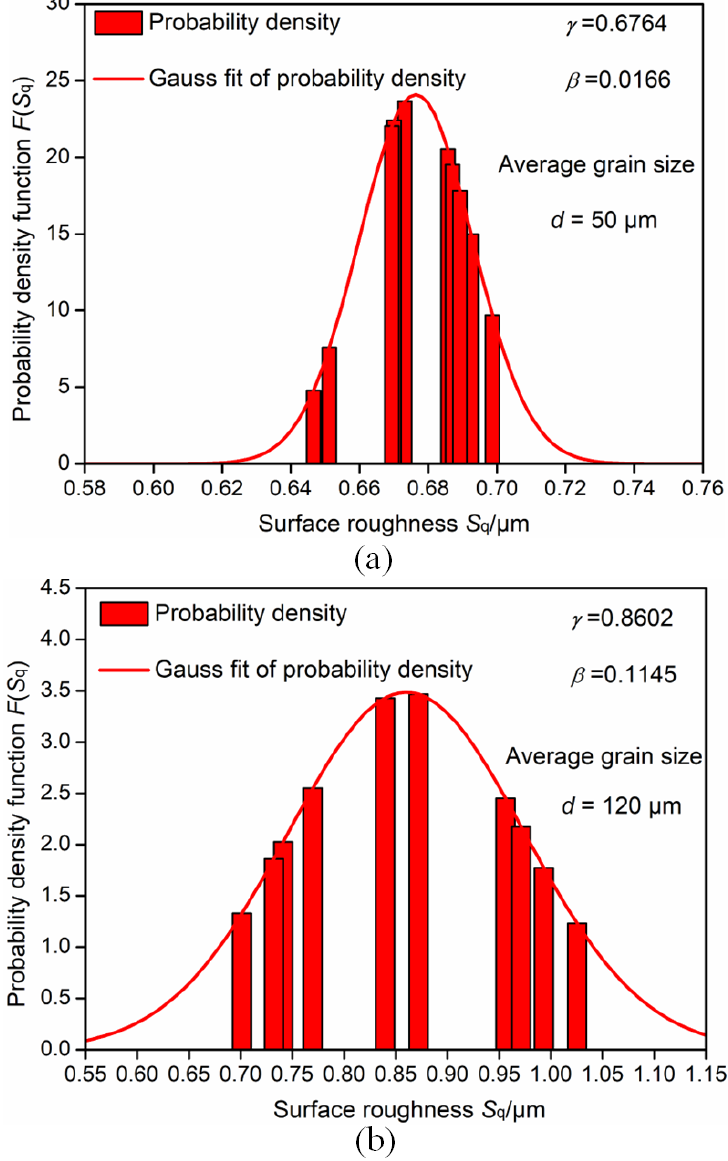
Figure 12. Probability density function of roughness with random grain orientations. ( a ) d = 50 μm; and ( b ) d = 120 μm.